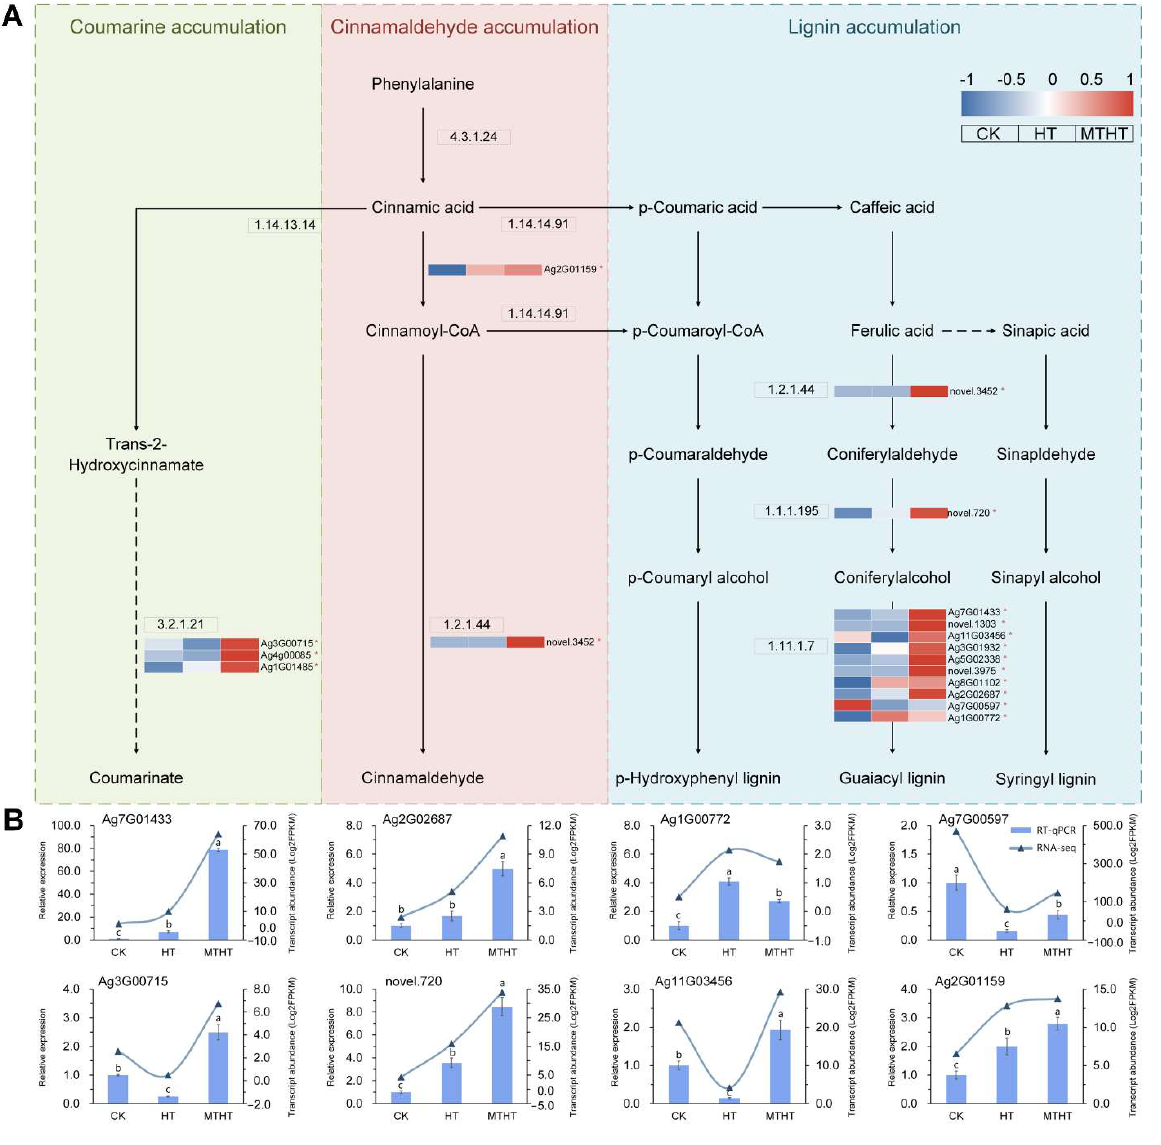
Figure 7. ( A ) Metabolite transformation and gene expression changes in the pyruvate metabolism pathway under heat stress. Red (up-tuned) and blue (down-tuned) in the heat map represent gene expression trends. * mean the gene is DEGs. ( B ) RT-qPCR analysis of genes in key pathway under heat treatment. Different letters (a–c) indicate significant differences, while the same letter indicates no significant differences. The column shape represents the relative expression of genes in RT-qPCR, and the curve with triangles represents the RNA-sequencing data.